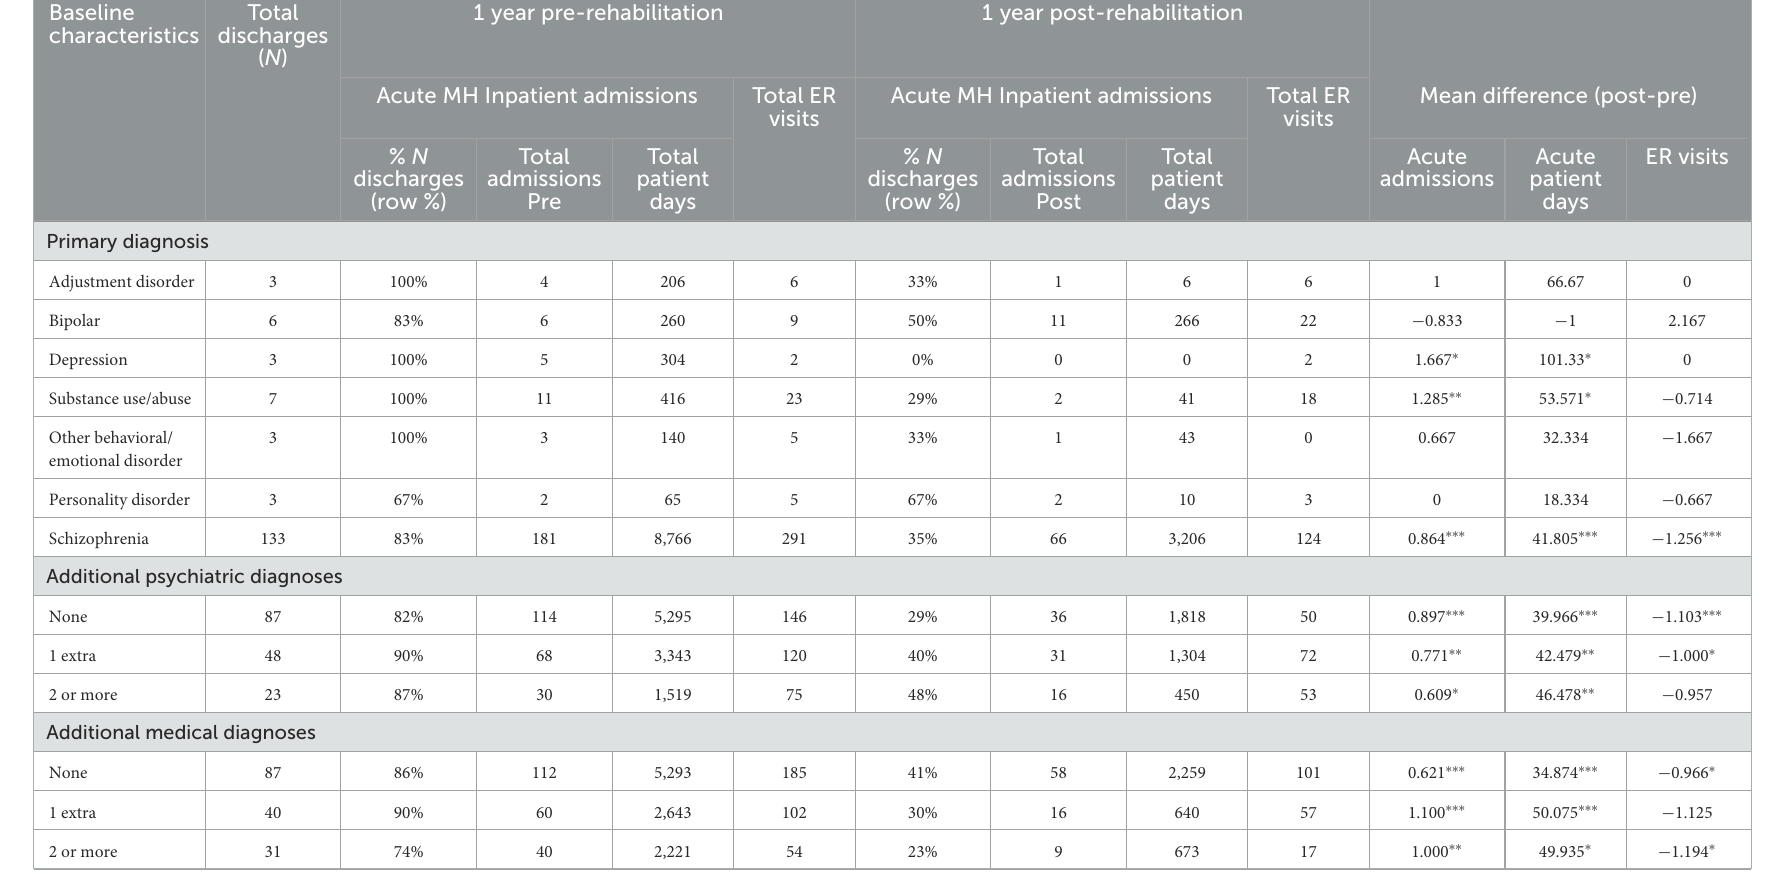
TABLE 3 Summary of the outcomes examining the length of stay, admission rate, and ER visits against different variables. Baseline